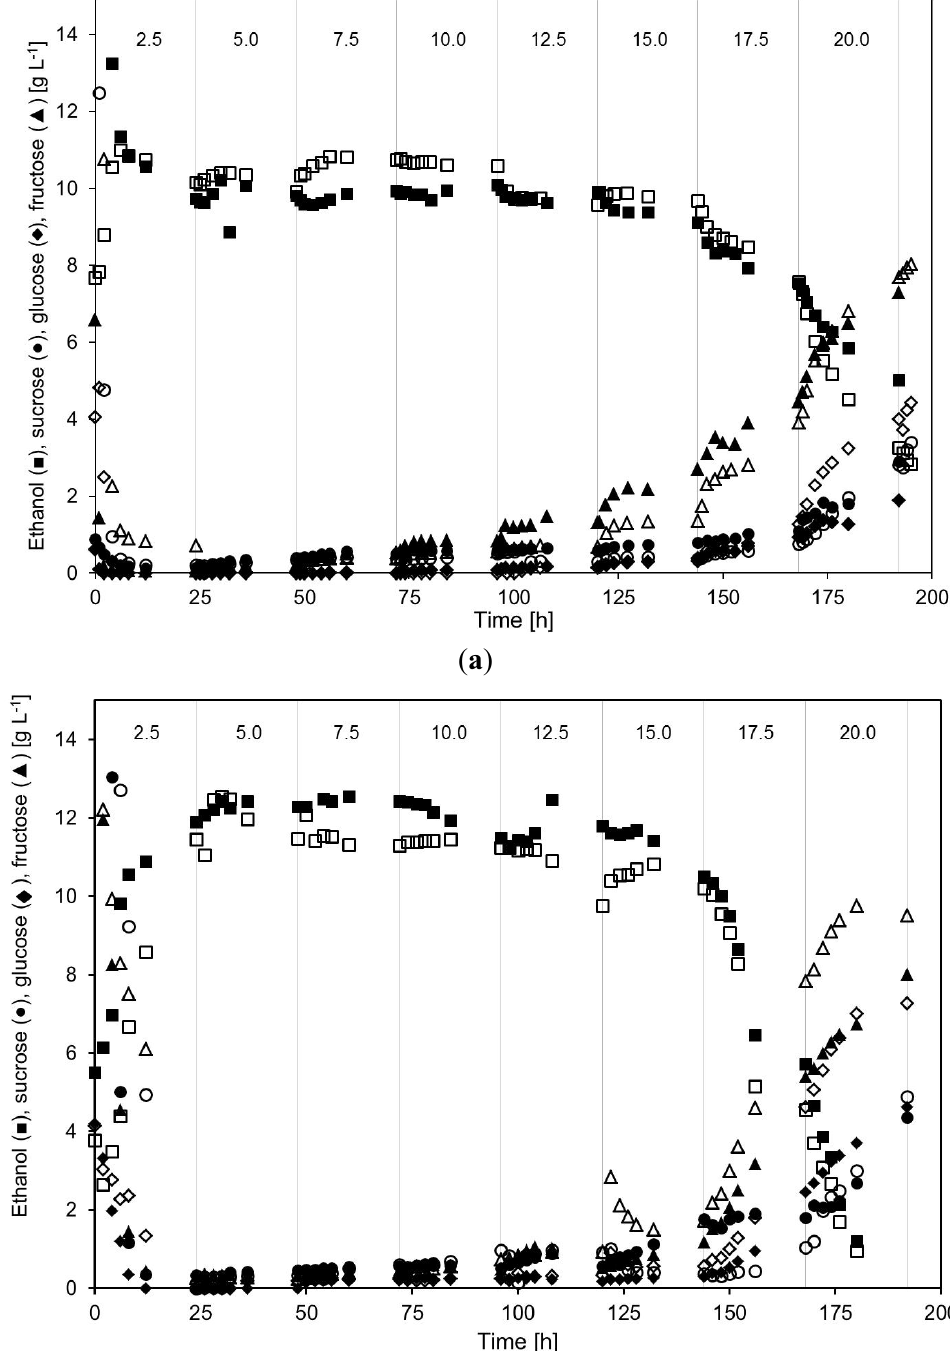
sugar, the ethanol yield and concentration should therefore have been higher than in the cultivations at lower yeast concentration. Figure 2. Concentration of ethanol, sucrose, glucose and fructose in the outflow from the MBR, during two separate cultivations (closed) and (open symbols) at very high ( a ) and high ( b ) yeast concentration. The total acetic acid concentration in the feed medium was changed every 24 h (vertical lines). The numbers at the top of the figures denote the approximate total acetic acid concentration (in g·L − 1 ) during each such 24 h